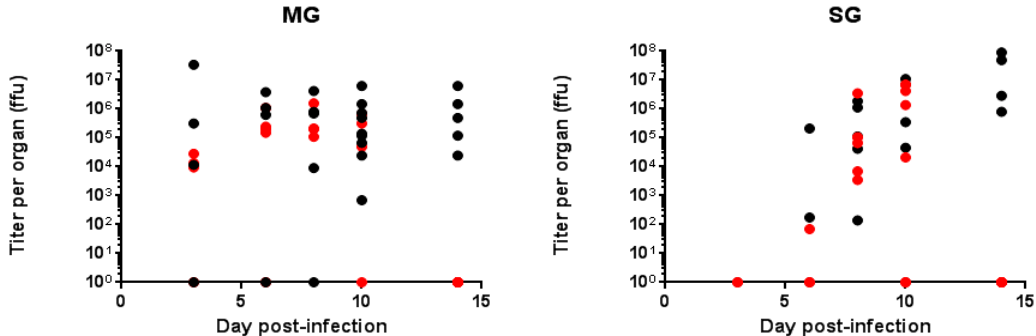
Figure 2. Titration of the Zika virus (ZIKV) in mosquito organs (MG and SG) at different days post-infection. Ae. aegypti (black circles) and Ae. albopictus (red circles) MG and SG were dissected at various dpi. ffu: focus forming unit.